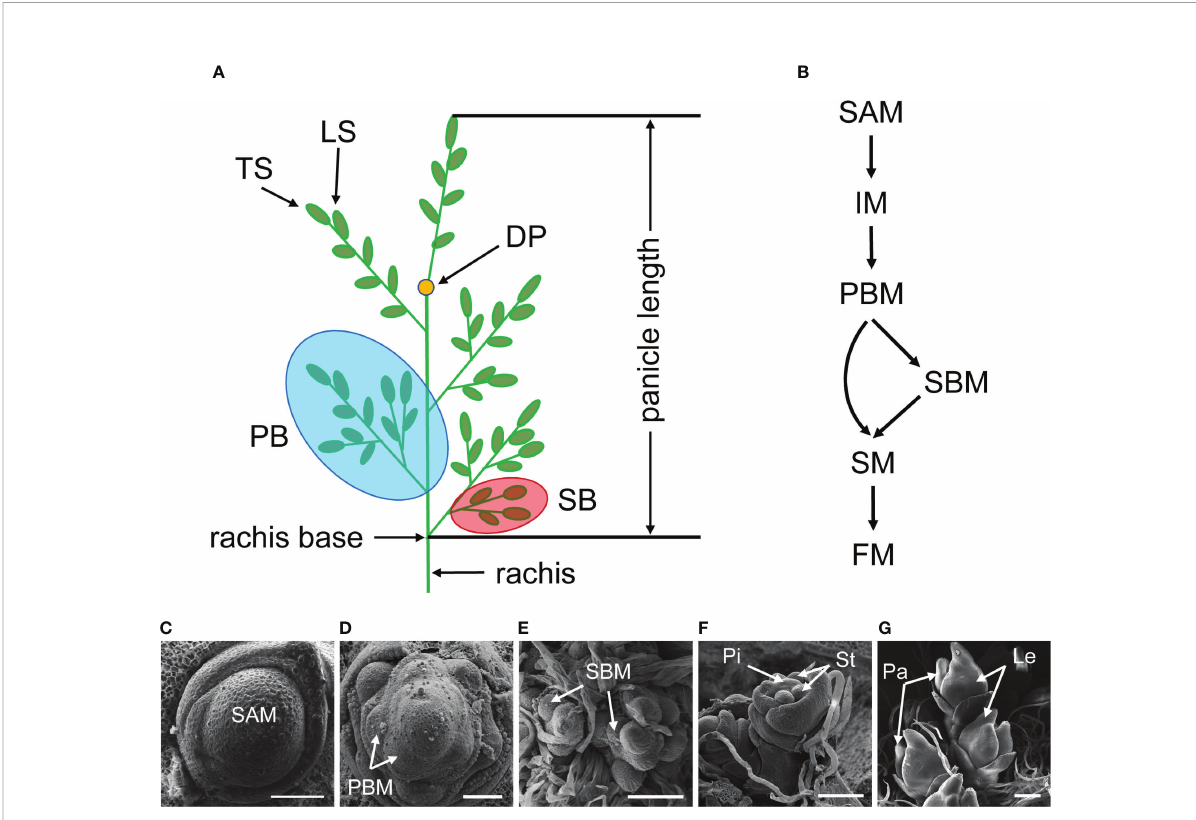
FIGURE 1 Rice in fl orescence architecture and development process. (A) Schematic diagram of the rice in fl orescence. The rice in fl orescence is also called “ panicle ” that primarily contains a rachis, branches and spikelets. DP, degenerate point of rachis; PB, primary branch; SB, secondary branch; LS, lateral spikelet; TS, terminal spikelet. (B) A hypothesis of meristem identity conversion. SAM, shoot apical meristem; IM, in fl orescence meristem; PBM, primary branch meristem; SBM, secondary branch meristem; SM, spikelet meristem; FM, fl oral meristem. (C-G) Scanning electron micrographs (SEM) showing early stages of rice in fl orescence development. Pi, pistil; St, stamen; Pa, palea; Le, lemma. Bars = 50 m m in (C) and (D) ; Bars = 100 m m in (E, F) ; Bar = 200 m m in (G)